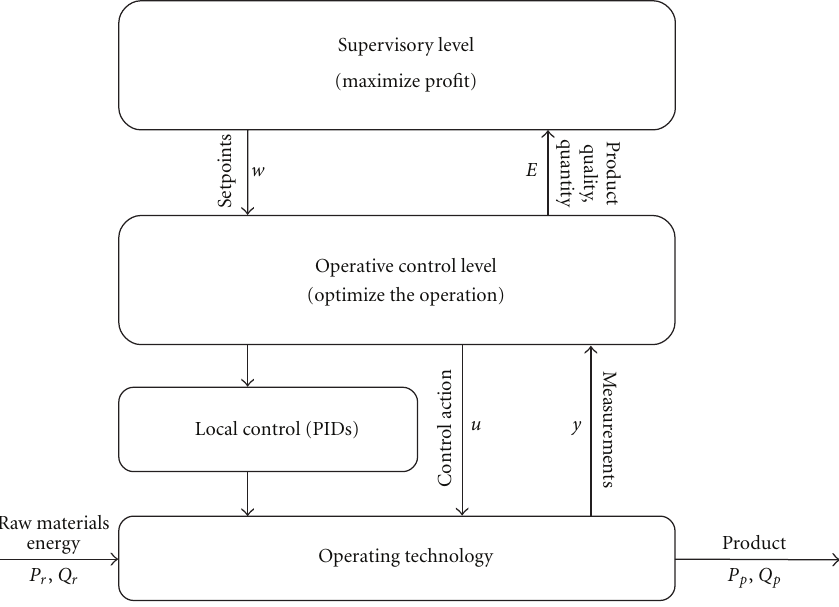
Figure 1: The layers of an economic optimization of an operating technology.